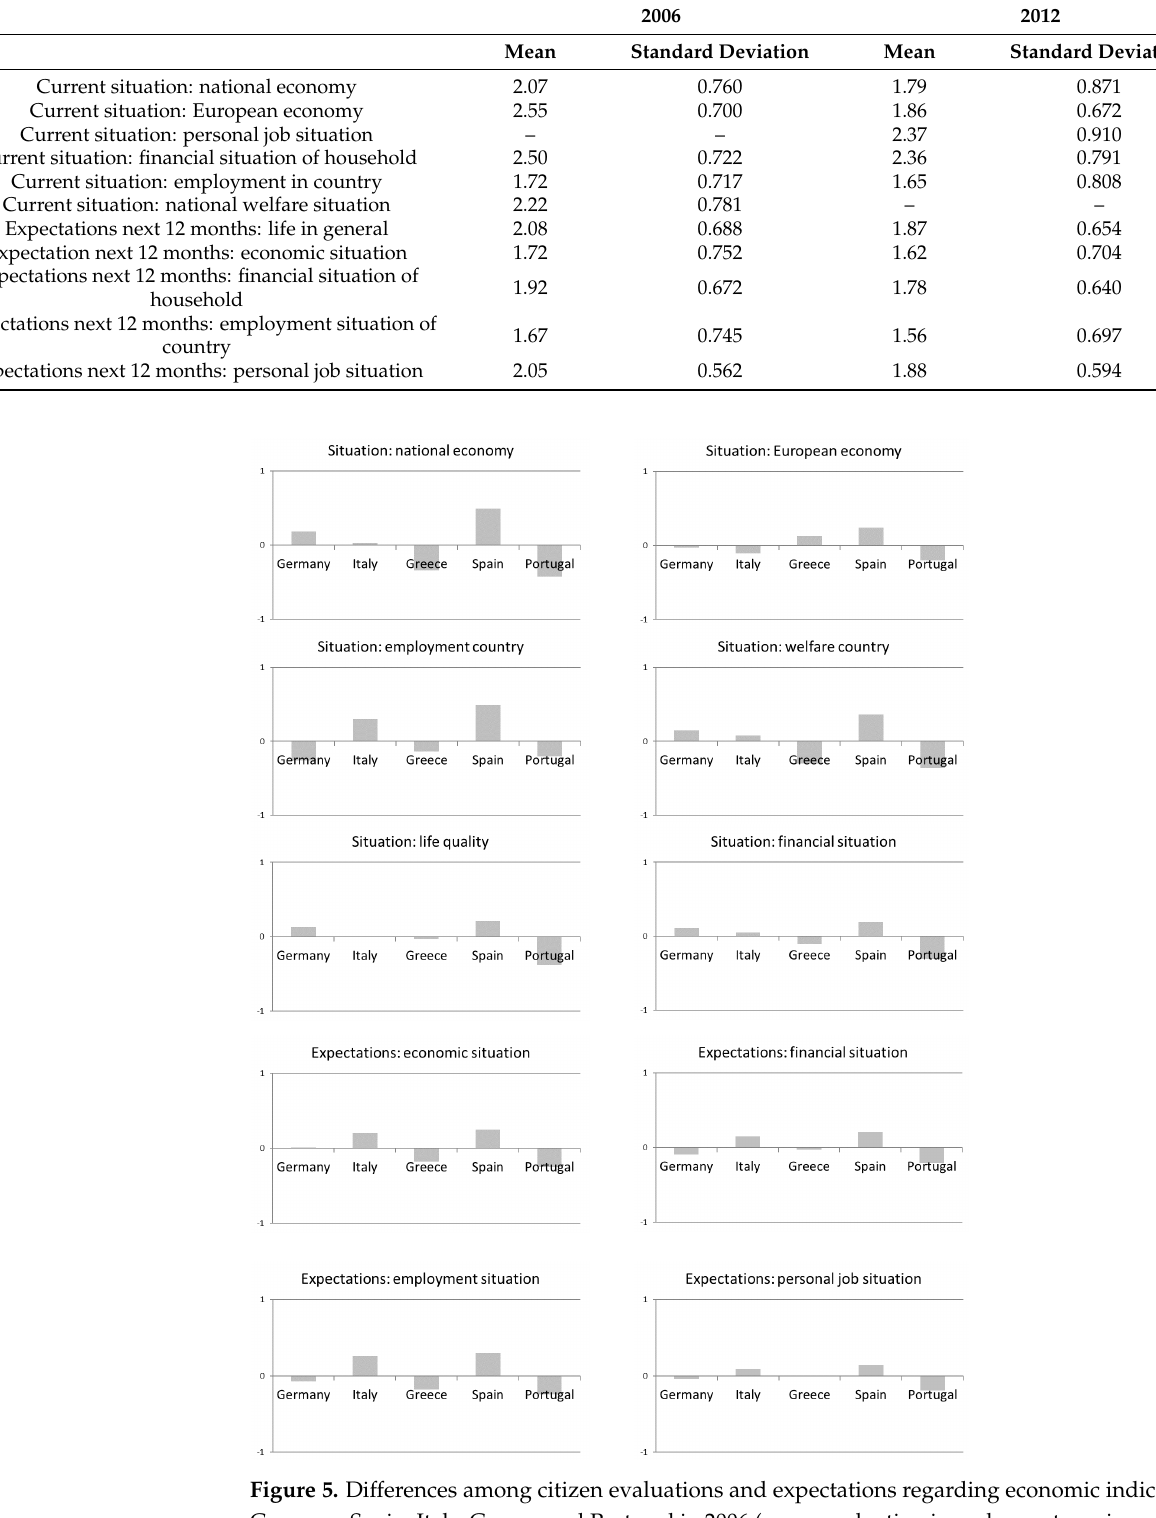
Table 3. Changes in the subjective perceptions of the economy by respondents in Germany, Spain, Italy, Greece, and Portugal from 2006 to 2012. Current situation: 1—very bad, 2—rather bad, 3—rather good, 4—very good. Expectations: 1—worse, 2—same, 3—better. Source is authors’ own elaboration from Eurobarometer 65.2 and 77.3.